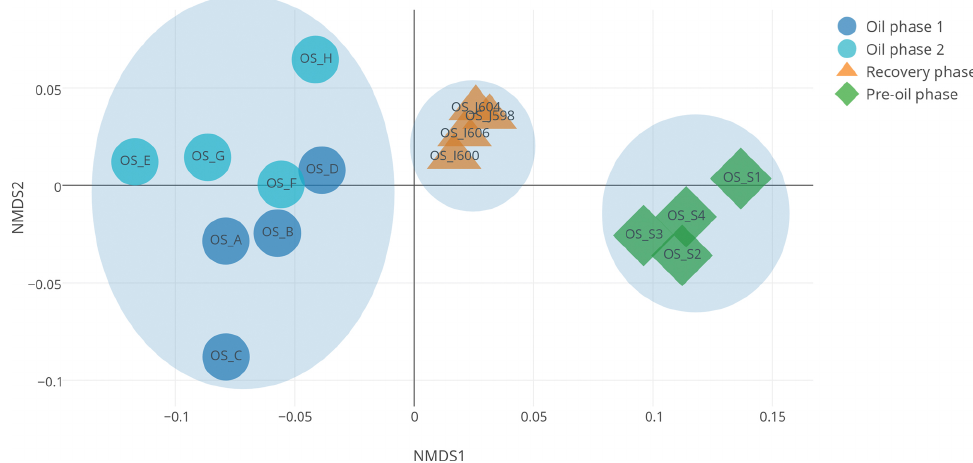
Figure 3: Microbiome functional capabilities of beach sand metagenomes from a study of the Deepwater Horizon oil spill (16) (BioProject PRJNA260285) differ across phases. The samples were collected from four phases, including Pre-oil phase (OS-S1, OS-S2, OS-S3 and OS-S4), Oil phase 1 (OS-A, OS-B, OS-C and OS-D), Oil phase 2 (OS-E, OS-F, OS-G and OS-H) and Recovery phase (OS-I600, OS-I606, OS-J598 and OS-J604). The distances between samples in this non-metric multidi- mensional scaling (NMDS) graph represent the variation between sample function profiles. Samples from Pre-oil phase, Oil phases and Recovery phase localize separately. Oil phase samples are closer to Recovery phase samples than to Pre-oil phase